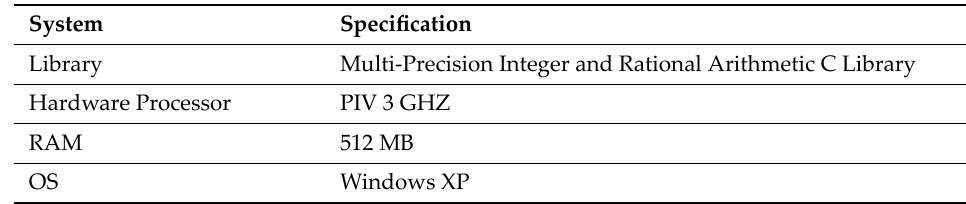
Table 3. Hardware and software specifications.